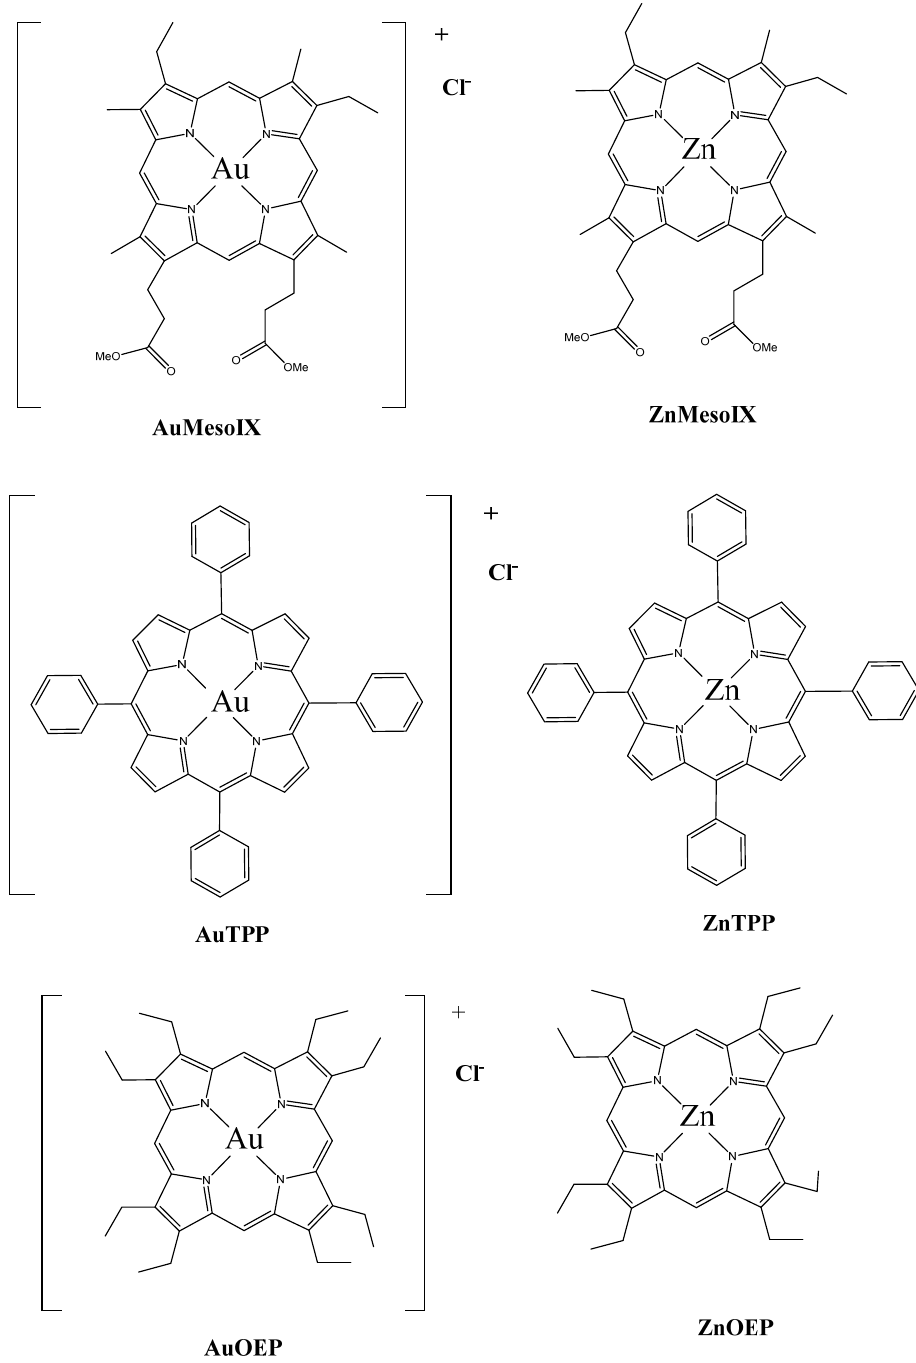
Figure 22. Chemical structures of gold(III) and zinc(II) porphyrin complexes [117].